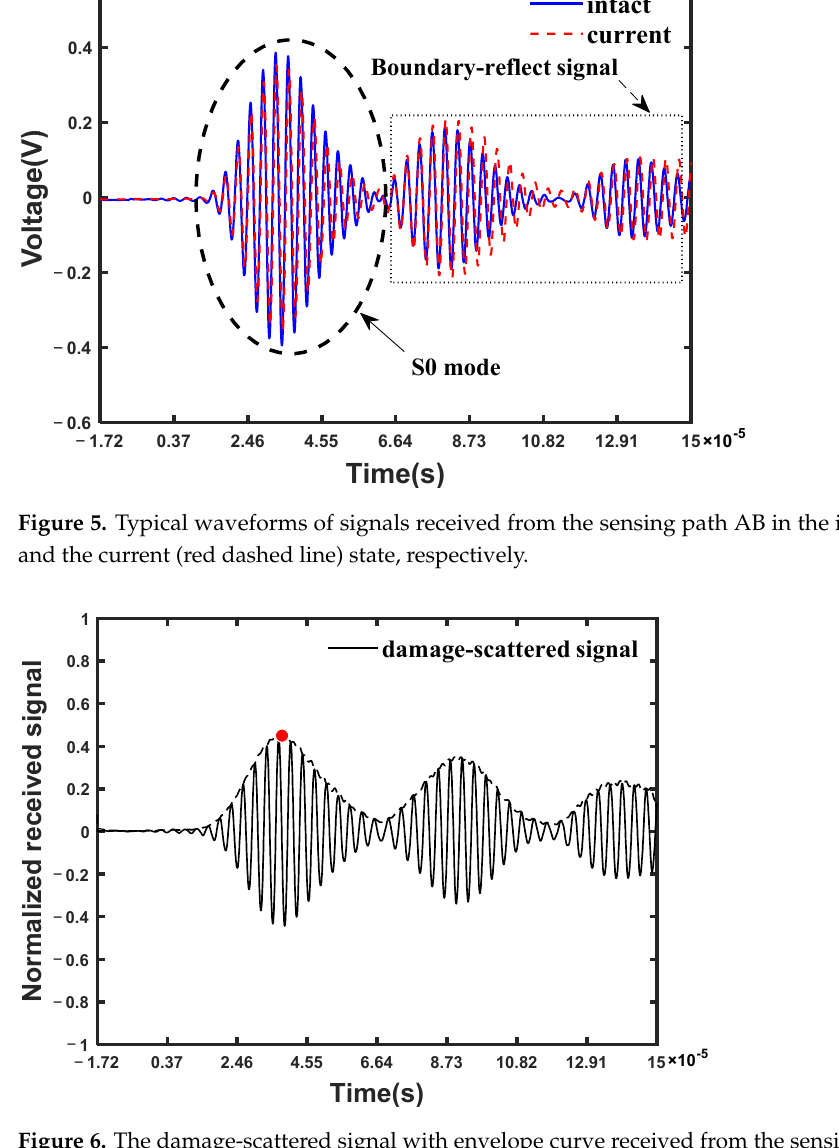
Figure 6. The damage-scattered signal with envelope curve received from the sensing path AB.